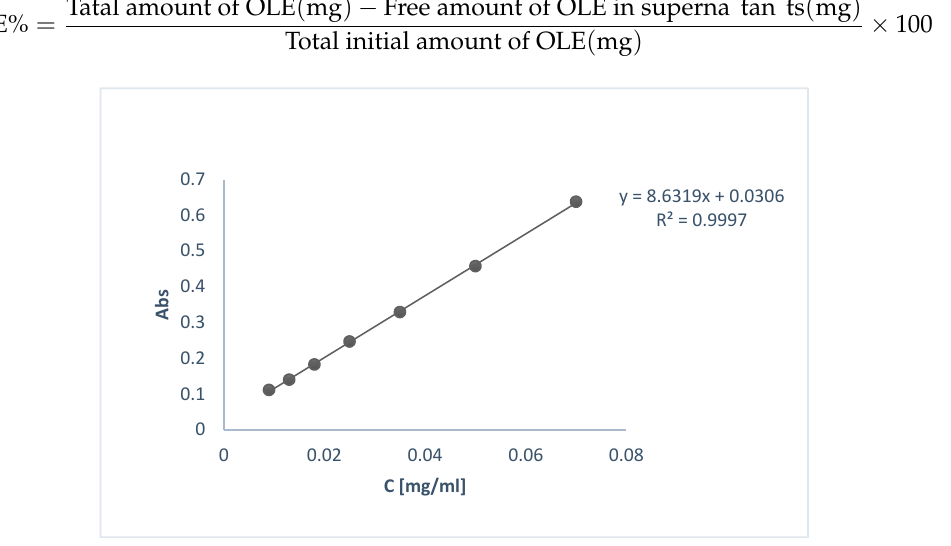
Figure 2. Calibration curve of OLE for the determination of EE% and in vitro release profile.